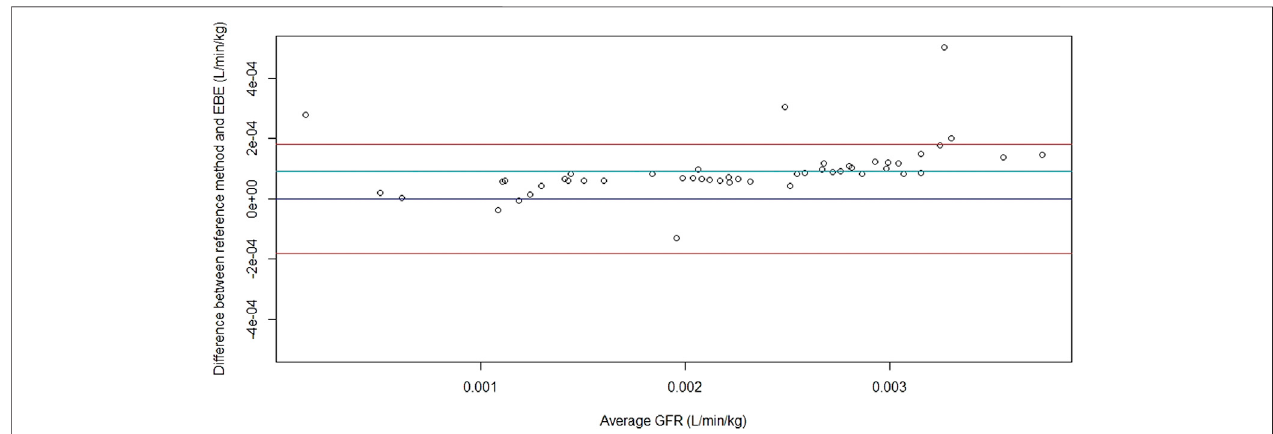
FIGURE 4 | The Bland – Altman plot of the comparison of GFR obtained with the formula Cl (cid:2) D/AUC in the previously published study by Pocar et al. (2019) and empirical Bayes estimates (EBE) ( fi ve sampling times available).